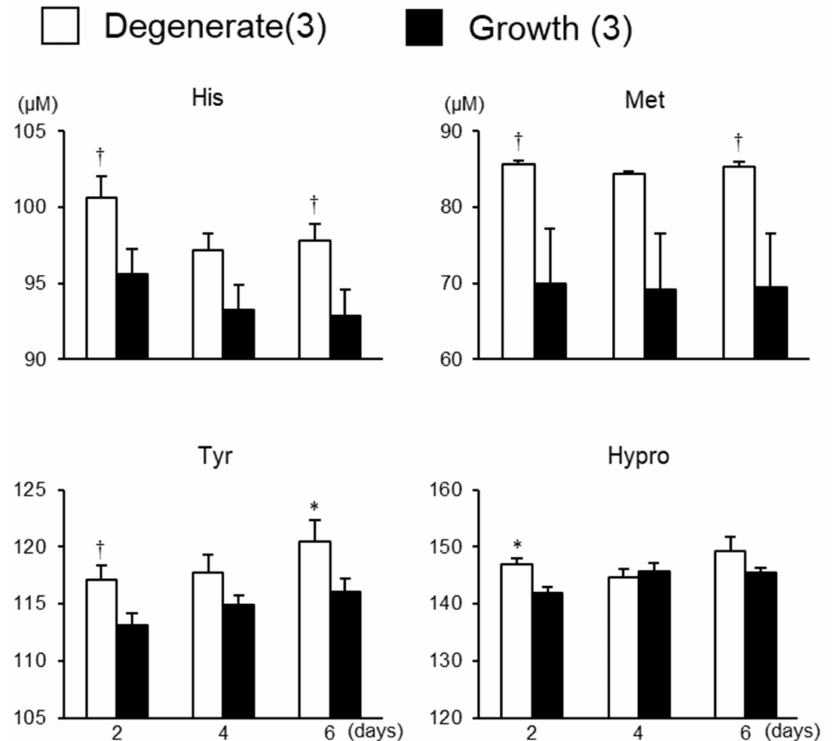
Figure 8. Concentrations of the molecular species that showed differences between the growth and degenerate groups in culture media. * An asterisk indicates a significant difference between the growth and degenerate groups ( p < 0.05). † A dagger indicates a tendency in the difference between the growth and degenerate groups ( p < 0.1). Numbers in parentheses indicate the number of follicles in each group. Error bars indicate SEM. Table 3. p -values associated with the types of culture (primordial vs. secondary) and culture periods (day 2 vs. day 4 vs. day 6) on amino acid